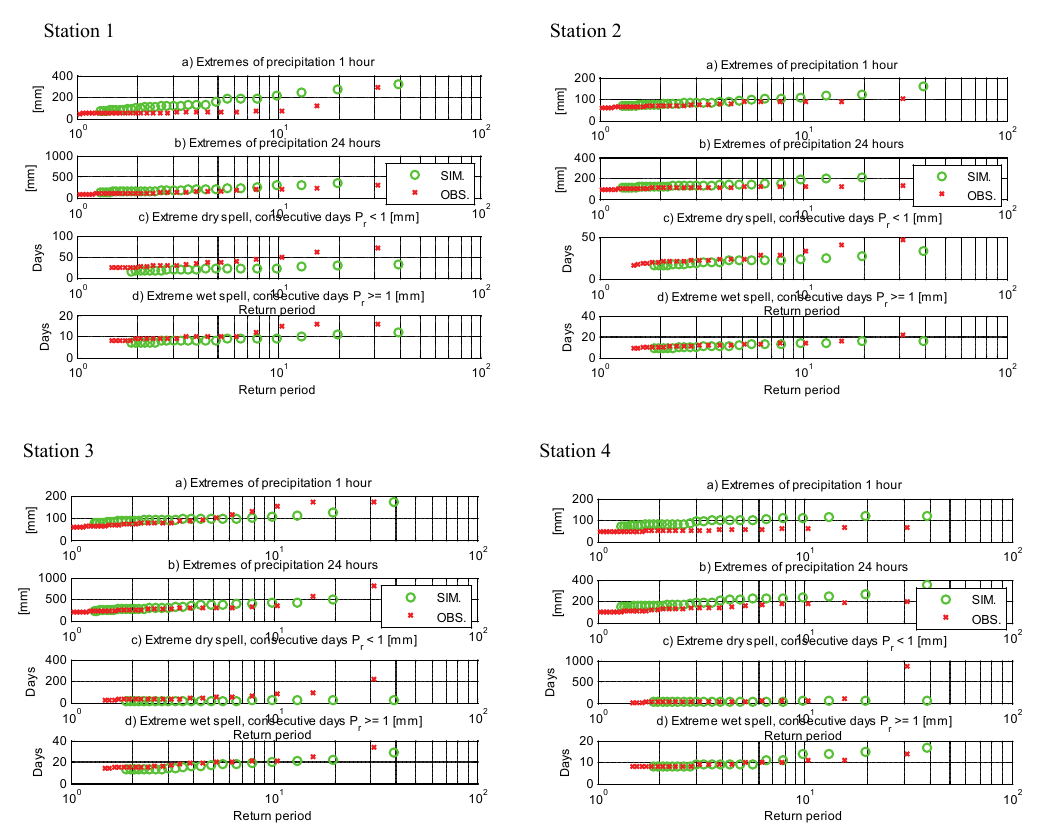
Fig. 5 A comparison between the observed and future values of extreme precipitations at (a) 1-h and (b) 24-h aggregation periods; (c) extremes of dry and (d) wet spell durations. Dry/wet spell duration is the number of consecutive days with precipitation depth lower/larger than 1